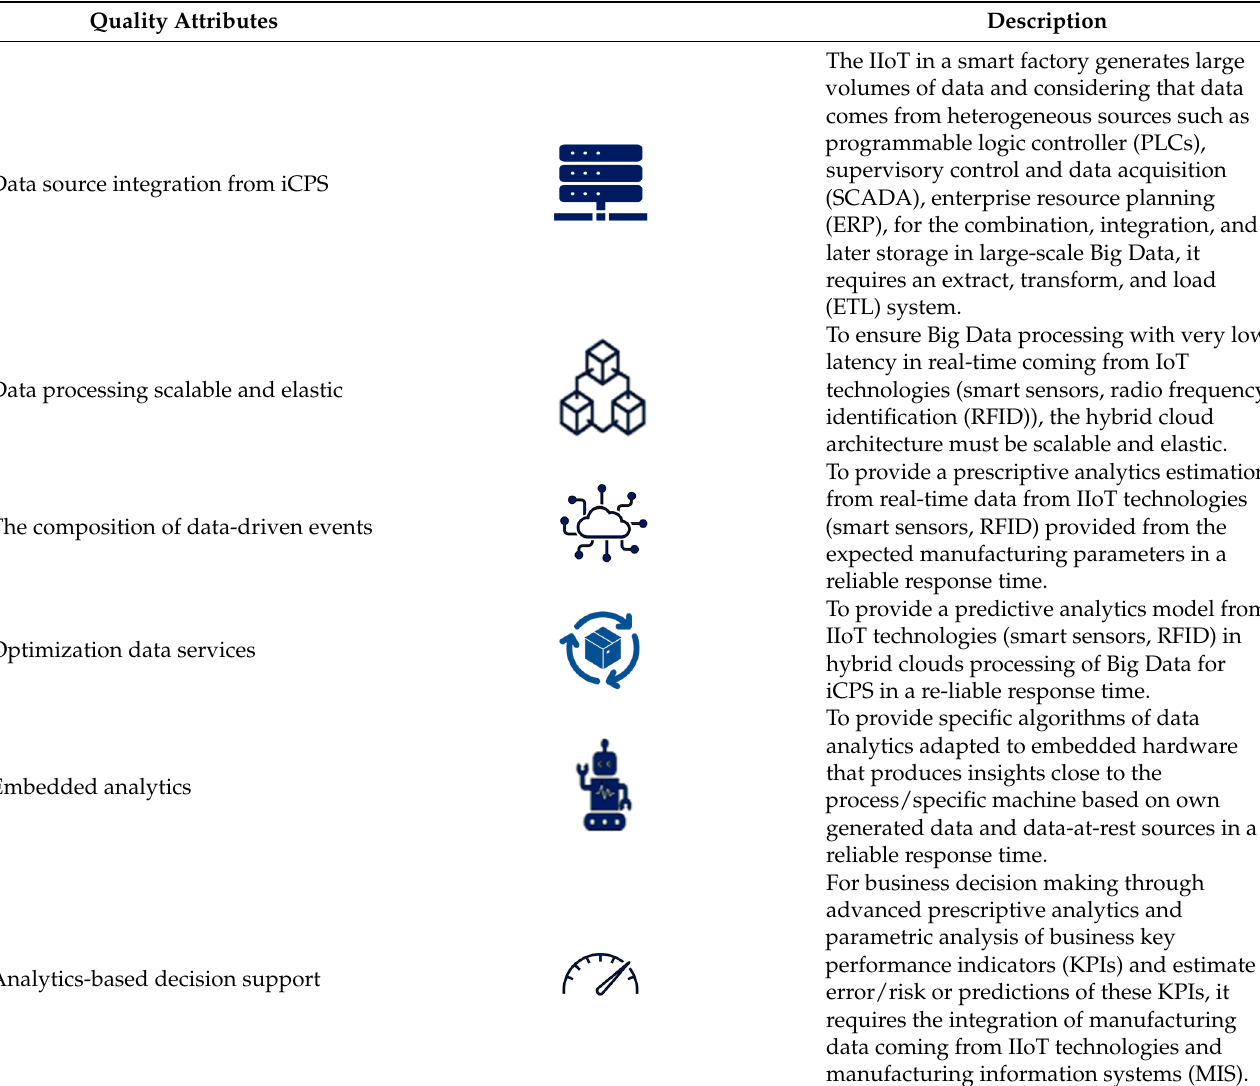
Table 2. Quality attributes for data management for industrial Big Data.